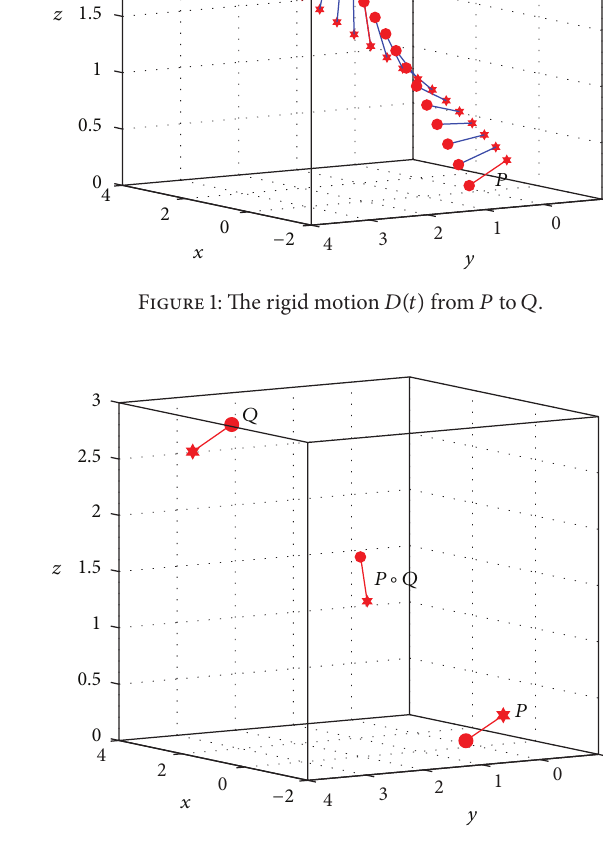
Figure 2: The Riemannian mean 𝑃 ∘ 𝑄